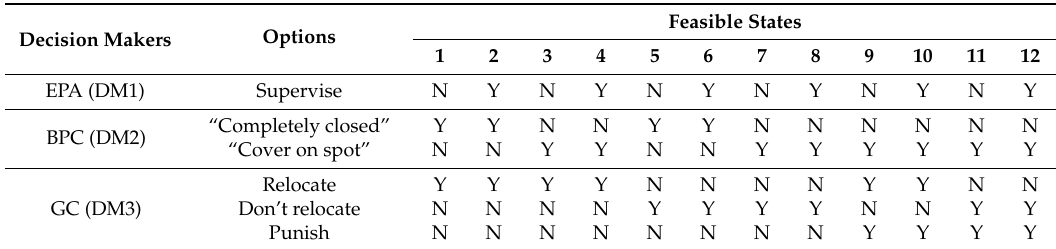
Table 3. Feasible states of Changzhou conflict.